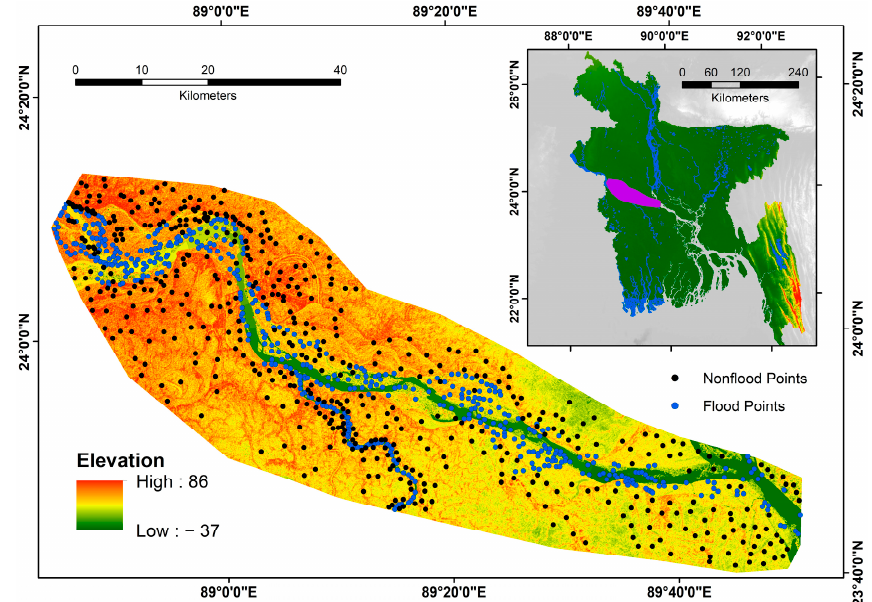
Figure 1. Map showing the location of the study region.